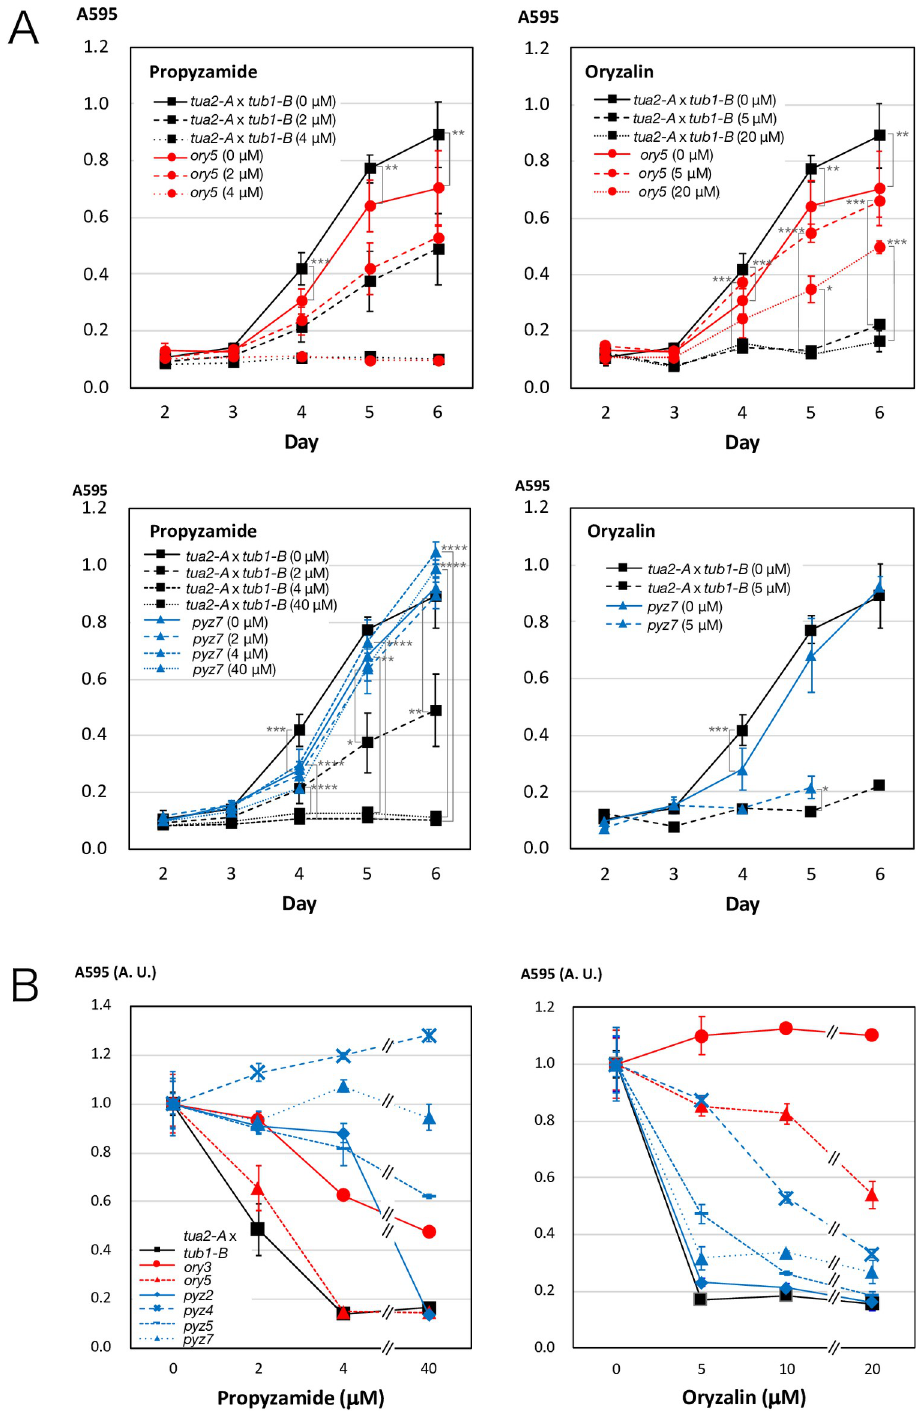
Fig 7. Growth profiles of representative missense mutants in the presence of propyzamide and oryzalin. Cells were cultured in growth medium containing different concentrations of propyzamide and oryzalin. Absorbance of the culture was measured at 595 nm every day. Error bars represent standard deviations in three independent measurements. (A) Growth curves of two representative strains, ory5 and pyz7 , compared with the parent strain tua2-A x tub1-B at two or three concentrations of drugs. ory5 is resistant to oryzalin but not to propyzamide. In contrast, pyz7 is resistant to propyzamide but not to oryzalin. � , P < 0.05; �� , P < 0.01; ��� , P < 0.0001; ���� , P < 0.00001 (ANOVA test). (B) Relative optical densities 5 days after the initiation of culture are plotted against the